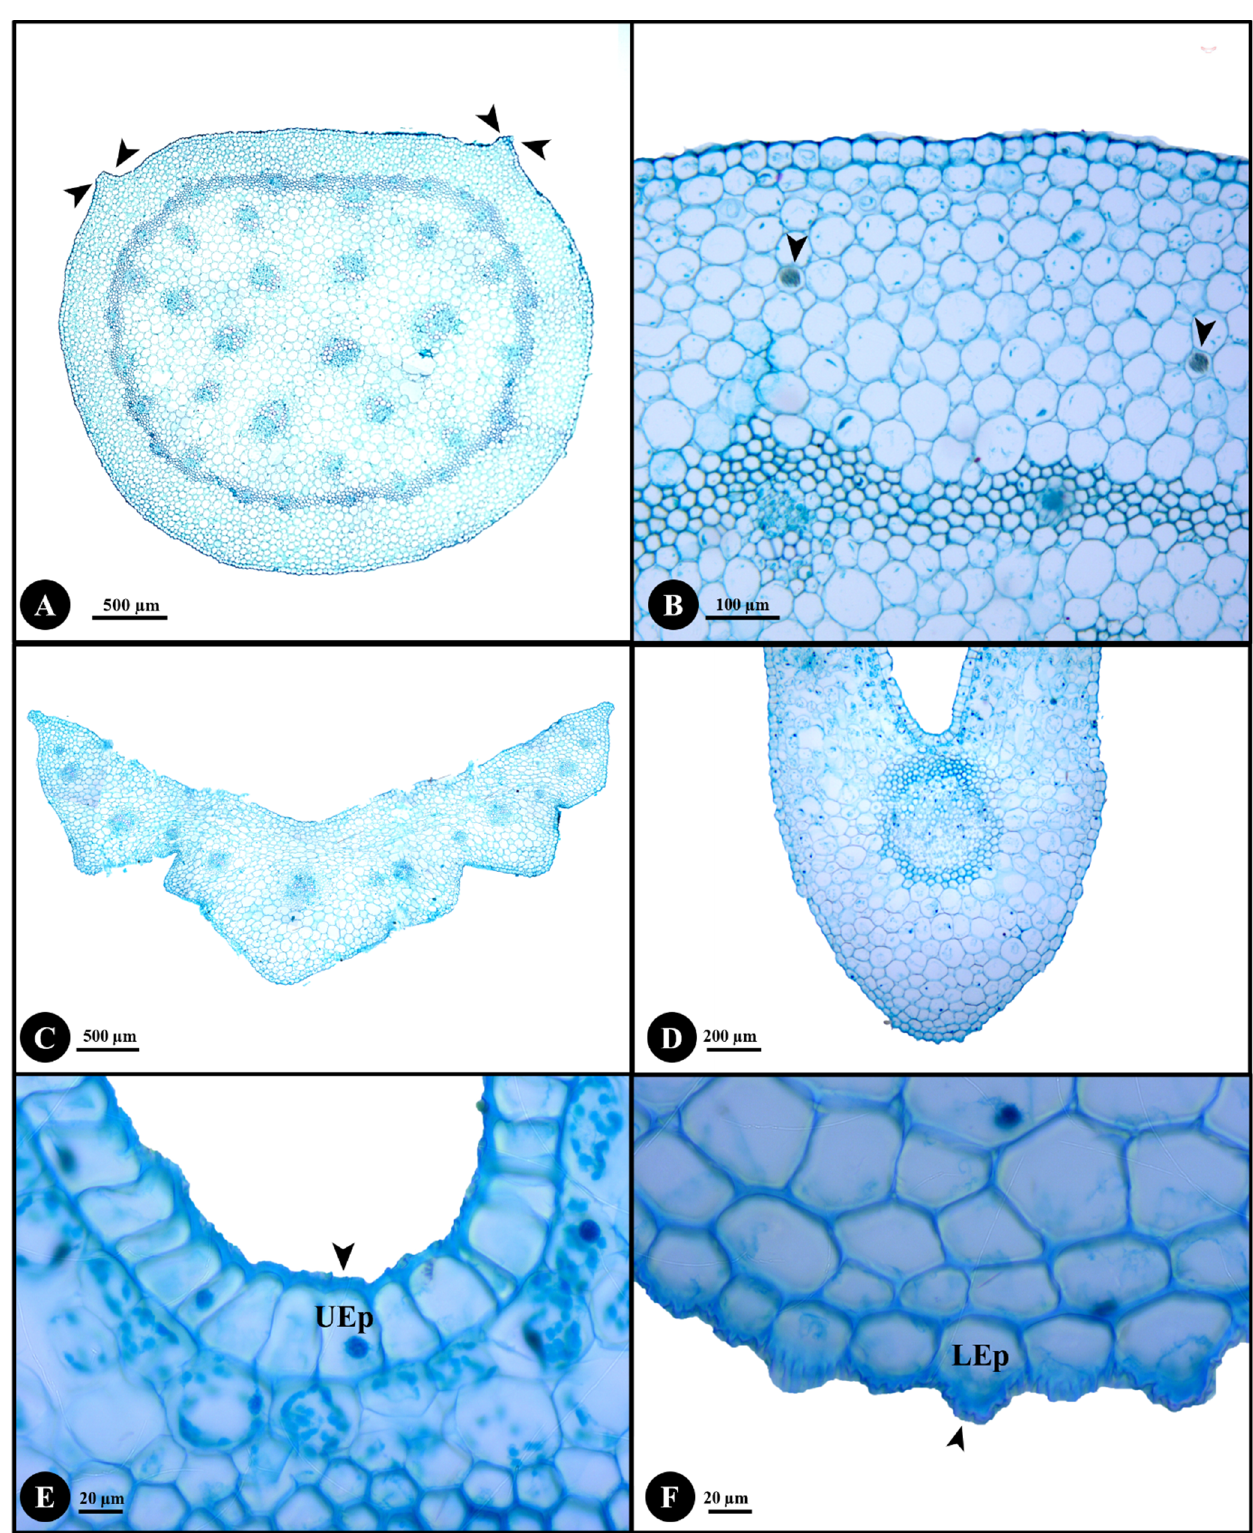
Figure 2. Anatomical characters of stem, petiole and midrib of Disporopsis longifolia . ( A ) Stem with ridges (arrowheads); ( B ) raphides (arrowheads); ( C ) petiole; ( D ) midrib; ( E ) echinate cuticle thickening (arrowhead) of upper epidermis; ( F ) echinate cuticle thickening (arrowhead) of lower epidermis; (Abbreviations: UEp, upper epidermis; LEp, lower epidermis).